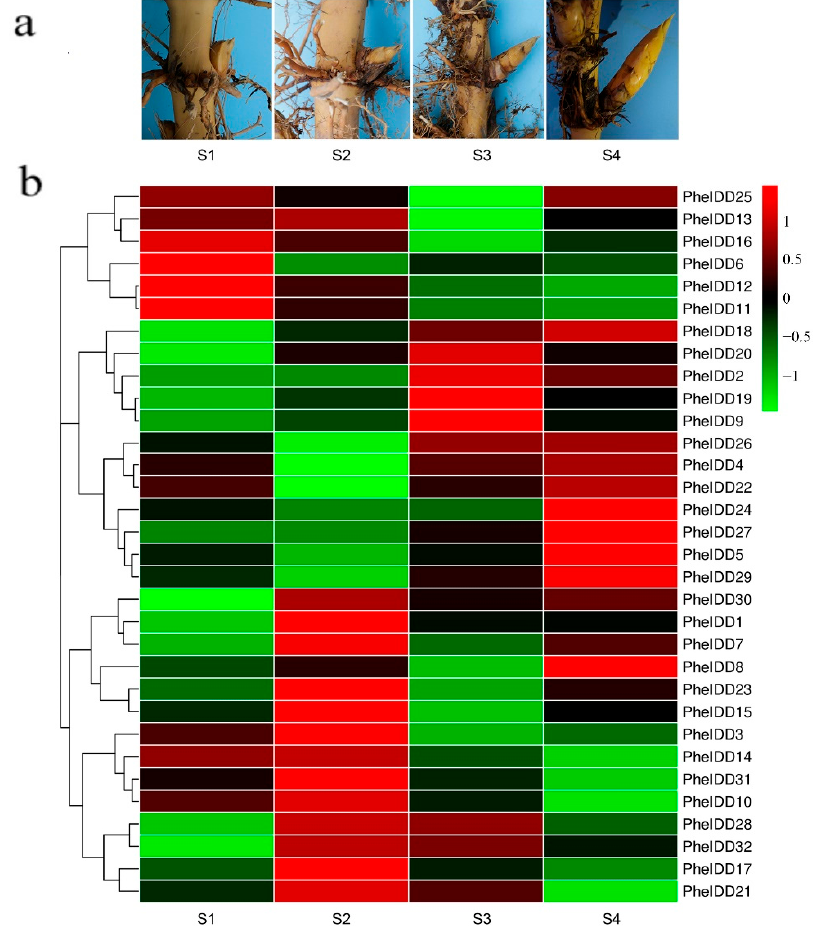
Figure 6. Expression patterns of PheIDD family genes in underground buds/shoots at different developmental stages. ( a ) Buds/shoots at different developmental stages on the rhizome. S1: 0.2-cm bud (dormant bud); S2: 2-cm bud (awakening bud); S3: 8-cm shoot; and S4: 16-cm shoot. ( b ) Expression heatmap of PheIDD genes in underground buds/shoots at different developmental stages. The color scale indicates the relative expression level. Green in color scale erected vertically at the right side of the picture indicates lower transcript abundance compared to the relevant control, and red indicates higher transcript abundance. The PheNTB gene was used as a reference. The qRT–PCR results were obtained from three biological and three technical replicates.